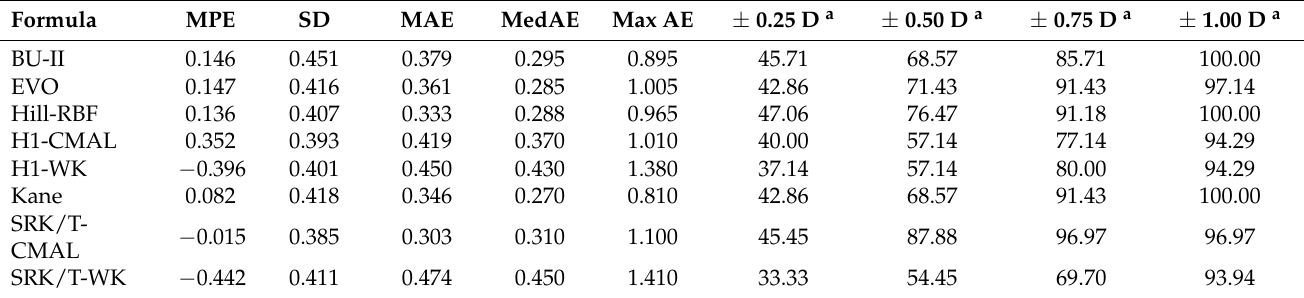
Table 2. Comparison of predictive outcomes.